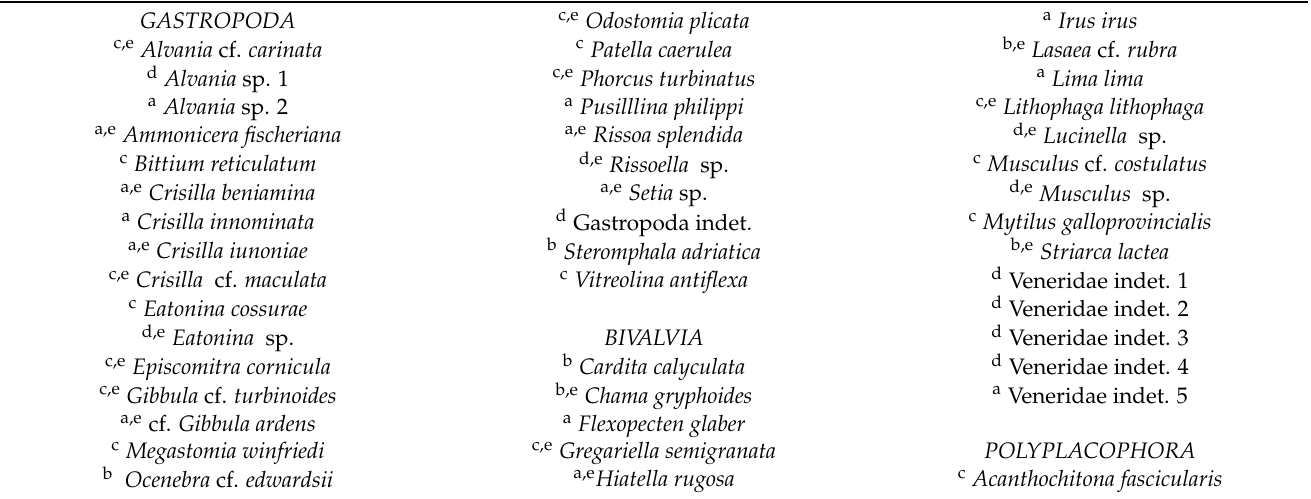
Table 2. Taxon list of mollusks isolated from C. officinalis